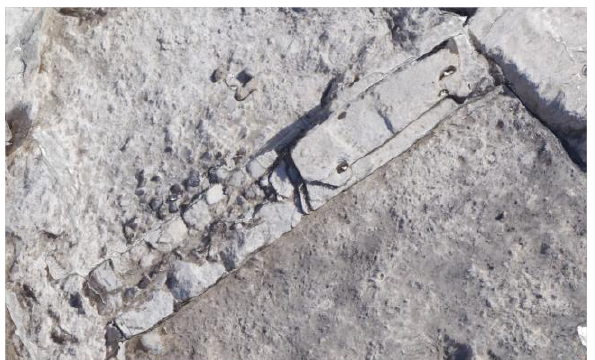
Figure 6. Detail of the workshop plan: